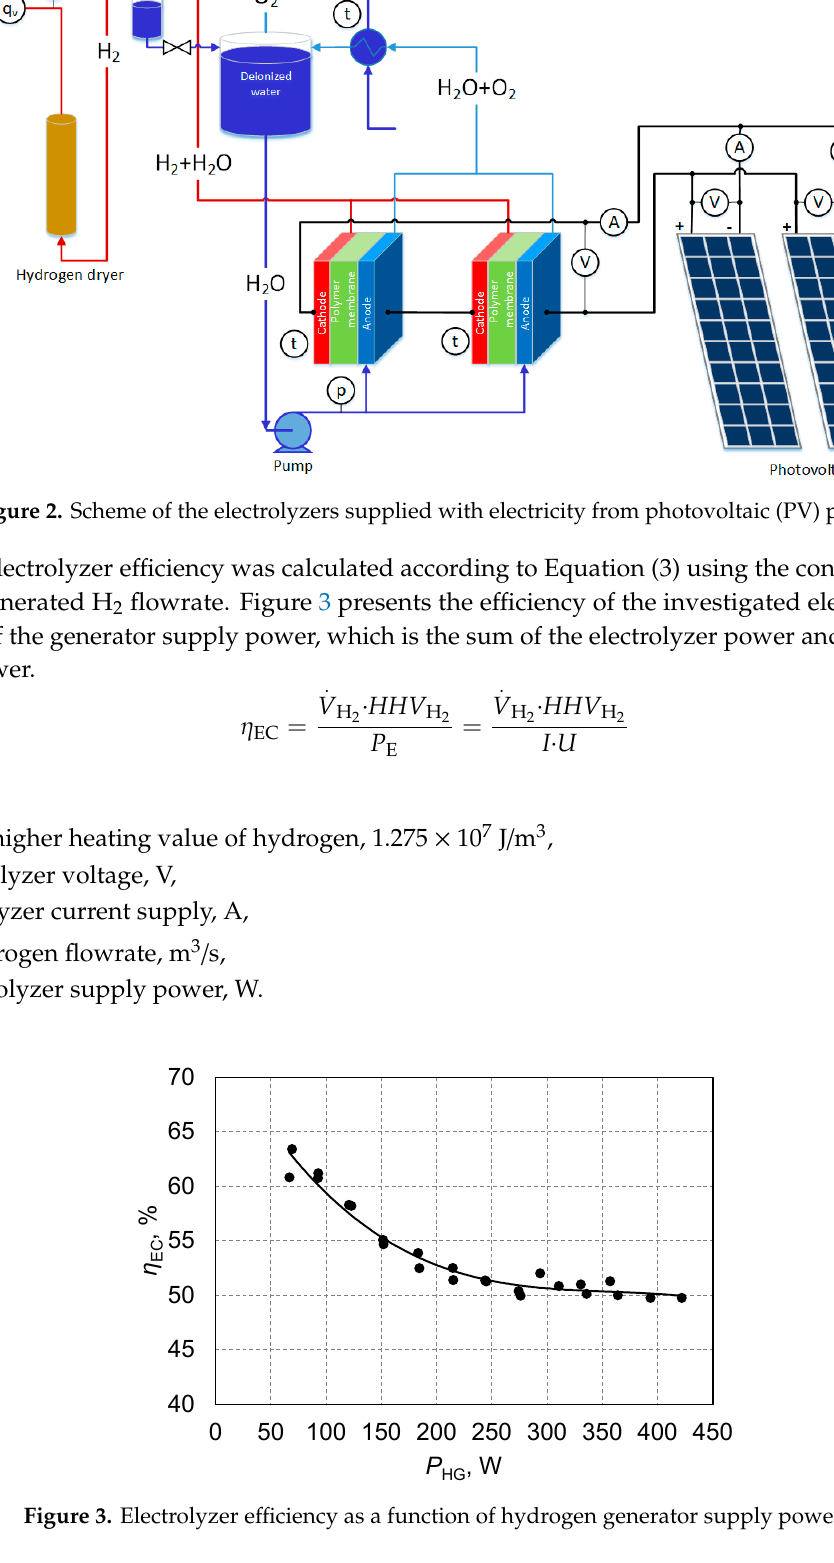
Figure 3. Electrolyzer e ffi ciency as a function of hydrogen generator supply power.